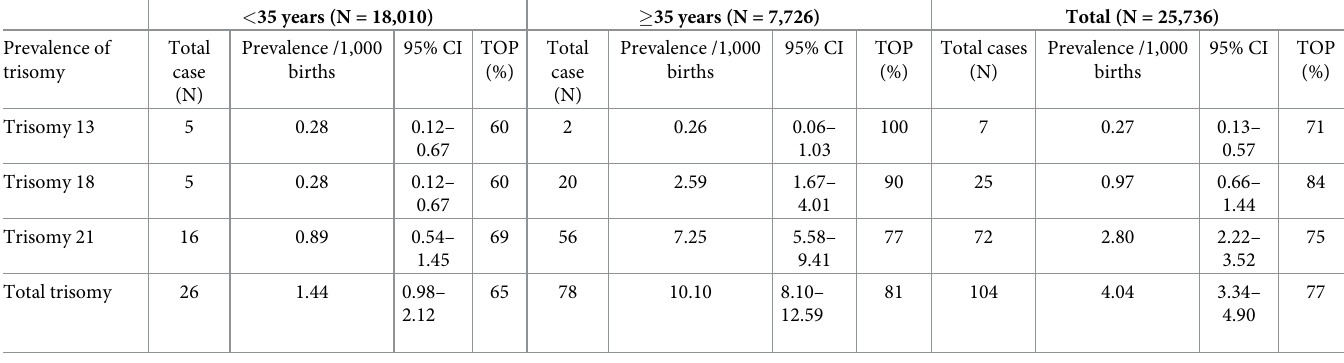
Table 2. Prevalence of